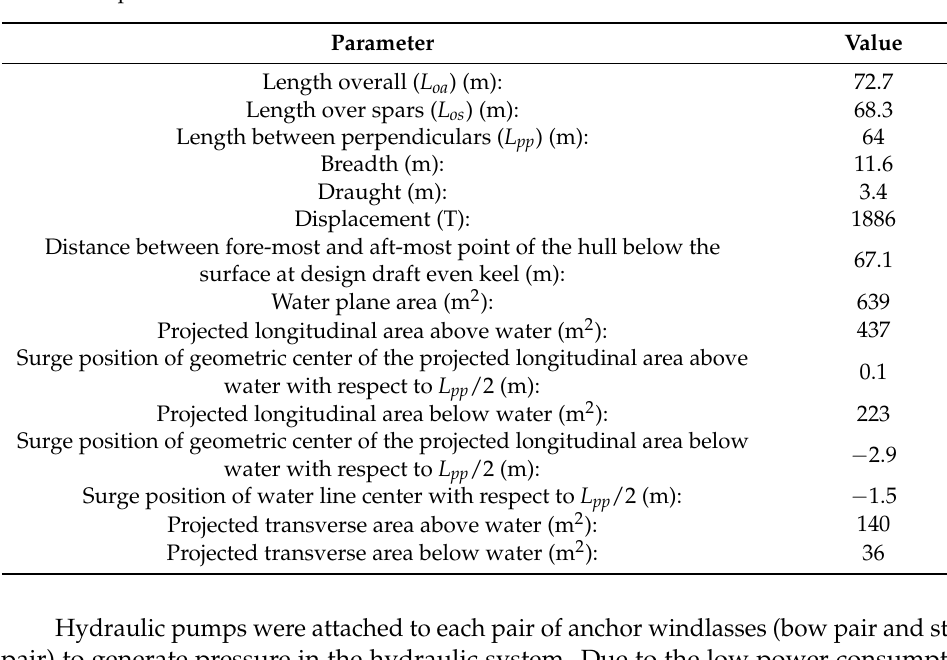
Table 2. Ship dimensions.